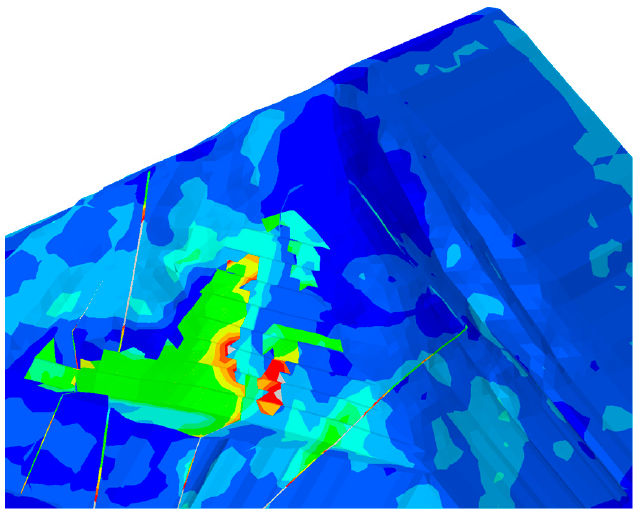
Figure 14. Distribution of slope plastic area.